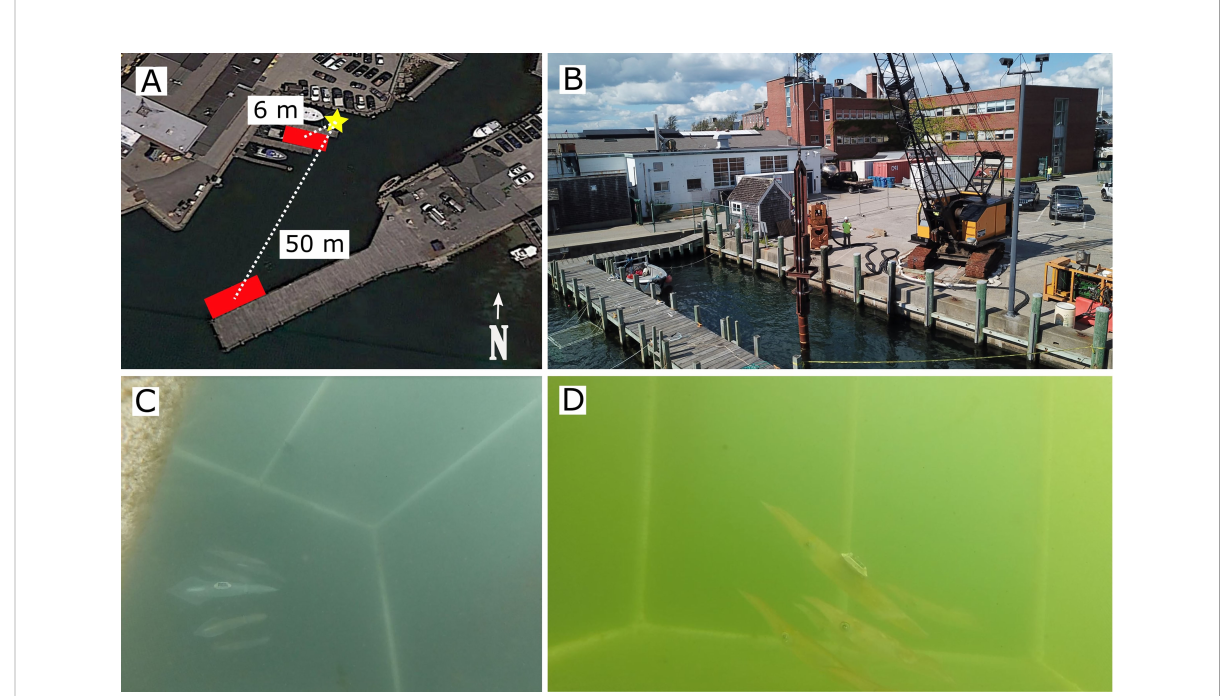
FIGURE 2 The experimental setup including a (A) map of the two sites: near (2-8 m) and far (50 m). The yellow star denotes the pile driving location, while the shaded red regions are the position of squid cages. The northern and western boundaries around the pile driving were solid sea walls. There were no physical barriers between the noise source and squid cages apart from a series of 0.3 m diameter piles supporting the dock slips. (B) Drone images during both impact pile driving. (C, D) Video footage from an experiment showing a focal tagged squid schooling with conspeci fi